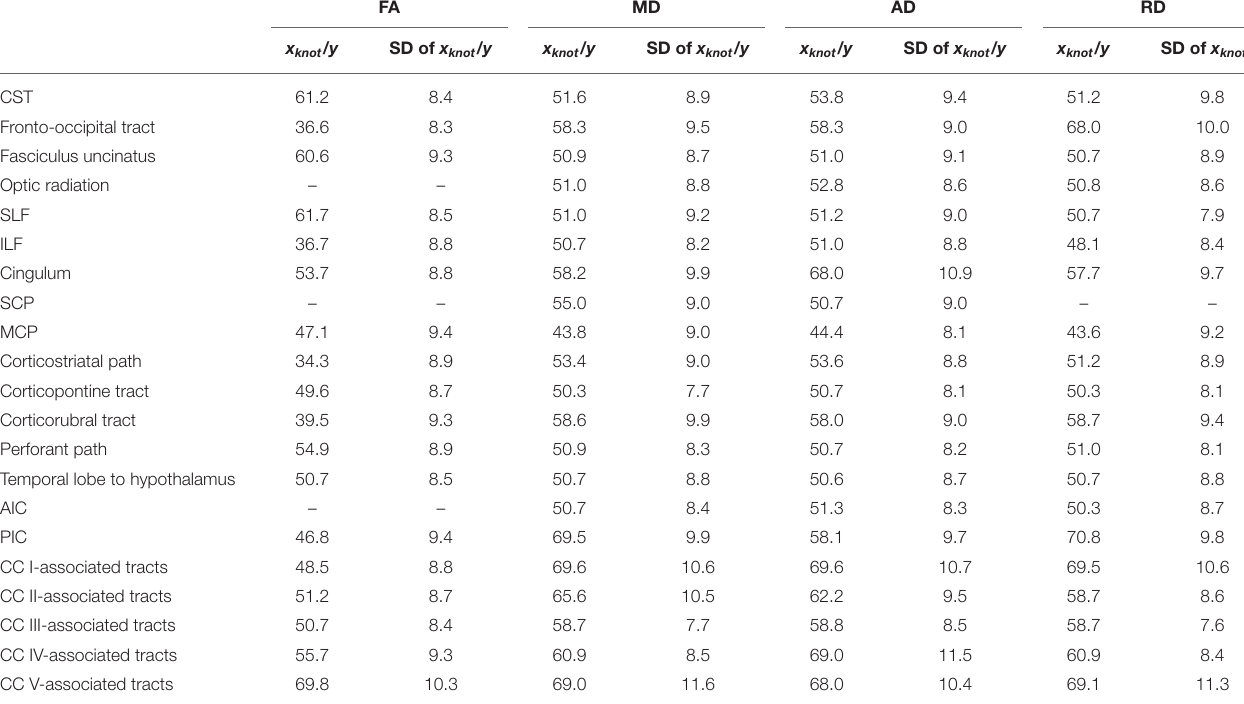
TABLE 3 | Knot positions of segmented linear regression and standard deviations (SDs) for fractional anisotropy (FA), mean diffusivity (MD), axial diffusivity (AD), and radial diffusivity (RD) in all investigated tract